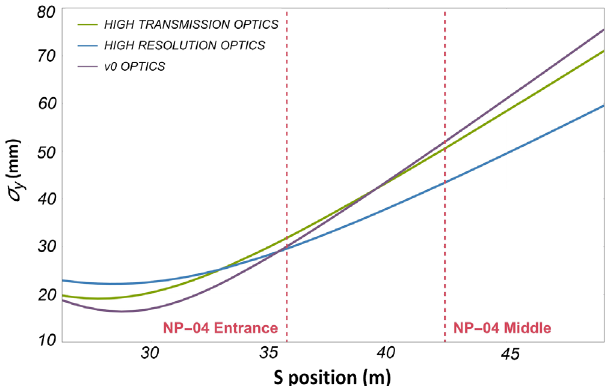
FIG. 4. Nonbending plane beam size in H4-VLE near the detector entrance for a 7 GeV =c beam, as simulated via PTC . In the nonbending plane, the high-transmission optics gives a better rate with small difference in the spot size, whereas the high resolution optics gives even smaller spot size at the entrance and the center of the cryostat, compared to v0